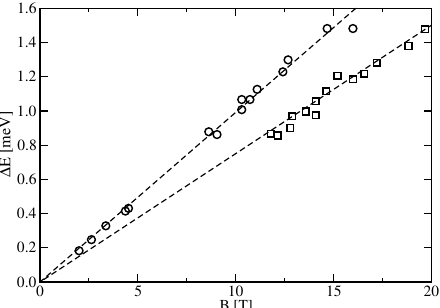
Figure 6. Magnetic field dependence of the two resonances. One is observed for all fields (open circles) and the other one (open squares) is only seen at high magnetic fields above 12 T [57]. The dashed straight lines correspond to a pure Zeeman splitting with g ef f ≈ 1.7 and g ef f ≈ 1.3, respectively. Data reproduced with permission from Ref. [58], American Physical Society,